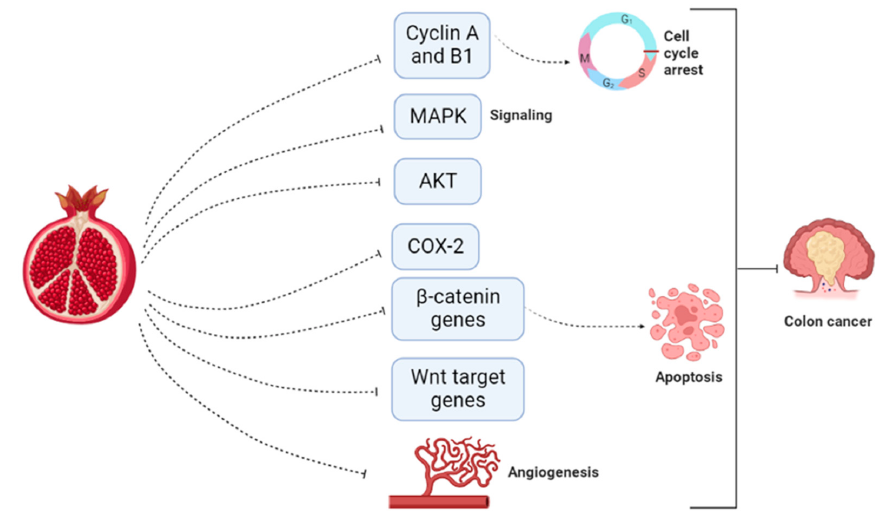
Figure 6 . Pomegranate effect in colon